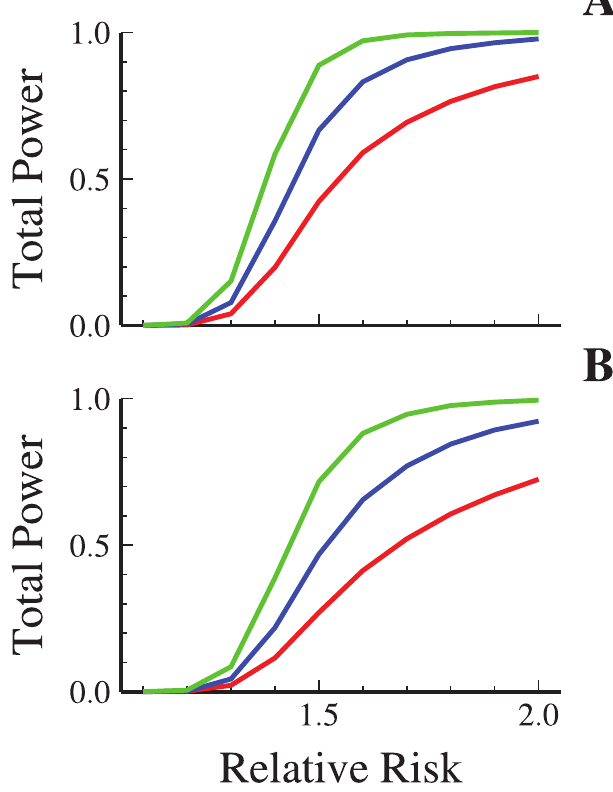
Figure 5. Power to Detect At Least One Risk Allele in CEU (Human- Hap550) and YRI (HumanHap650Y) in 1,000 Cases and 1,000 Controls under a Multiplicative Model Curves represent the cases where there is a single risk locus (red), two independent loci (blue), or four independent loci (green). The red lines are the single risk loci as shown in Figure 4. Under the multiple loci cases, the relative risk represents the minimum risk for all risk alleles and the corresponding power represents a lower bound on the power.